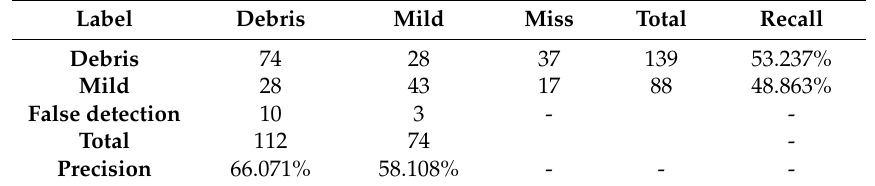
Table 3. The results of the SSD-convolution auto-encoder (CAE) method in the test dataset.